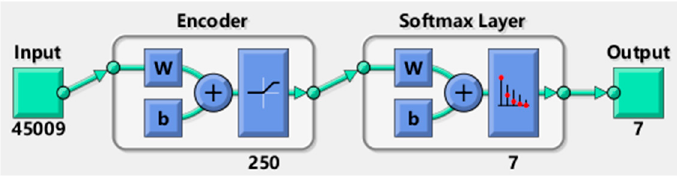
Figure 7. The structure of AE-based DNN.